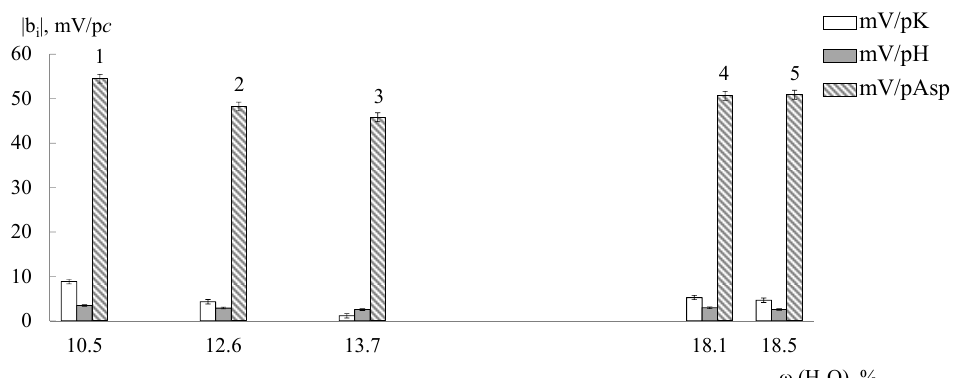
Figure 5. The dependence of DP-sensors’ sensitivity coefficients to ions in the Asp + KOH solutions (pH 3.99–8.20) on the water uptake (in the H + -form) for MF-4SC membranes + 3 wt.% SiO 2 (R) obtained via casting procedure: 1—10 mol.% R2; 2—5 mol.% R2; 3—10 mol.% R1; 4—initial sample; 5—5 mol.% R1.